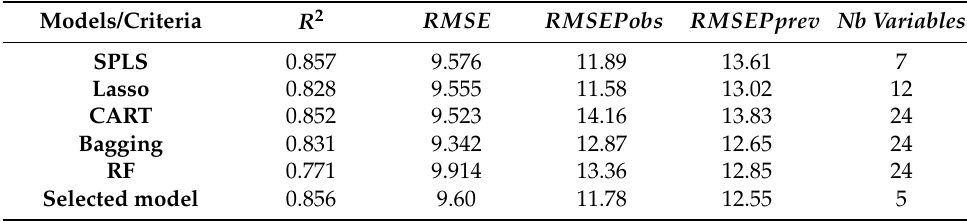
Table 3. A Comparison of the final model with other models according to RMSE , R 2 , RMSEP , and Nb Varibales